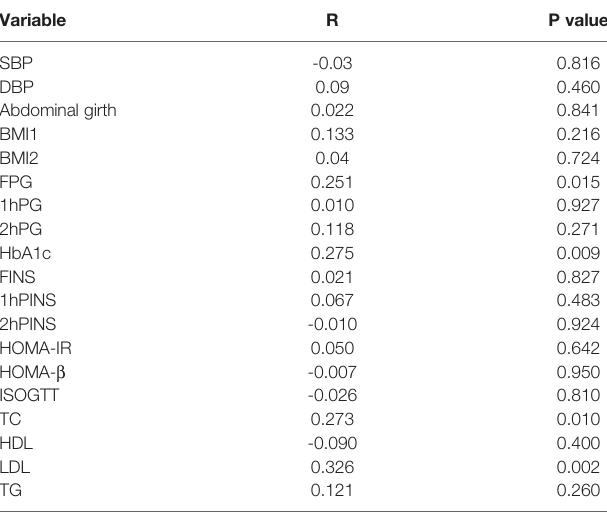
TABLE 2 | Partial Spearman correlations among PCSK9 and metabolic features in the GDM group. Variable R P